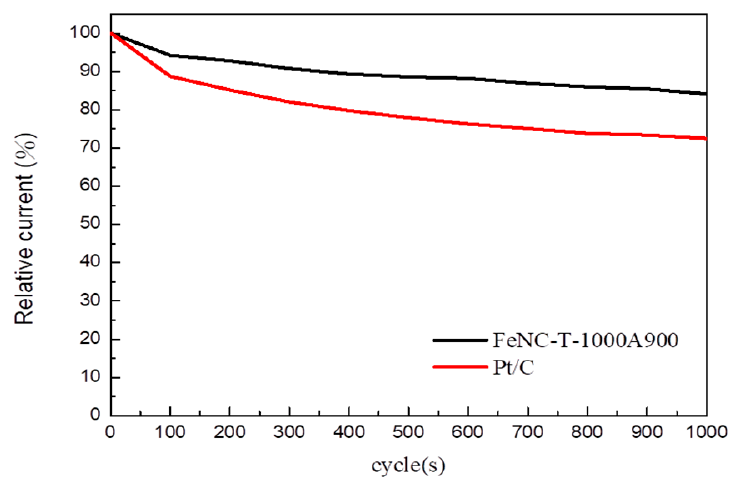
Figure 12. Relative current decay % of the LSV curves vs. cycling numbers recorded in O 2 -saturated 0.1 M HClO 4 at 1600 rpm and 100 mV/s for the FeNC-1000A900 and Pt/C catalysts, respectively.